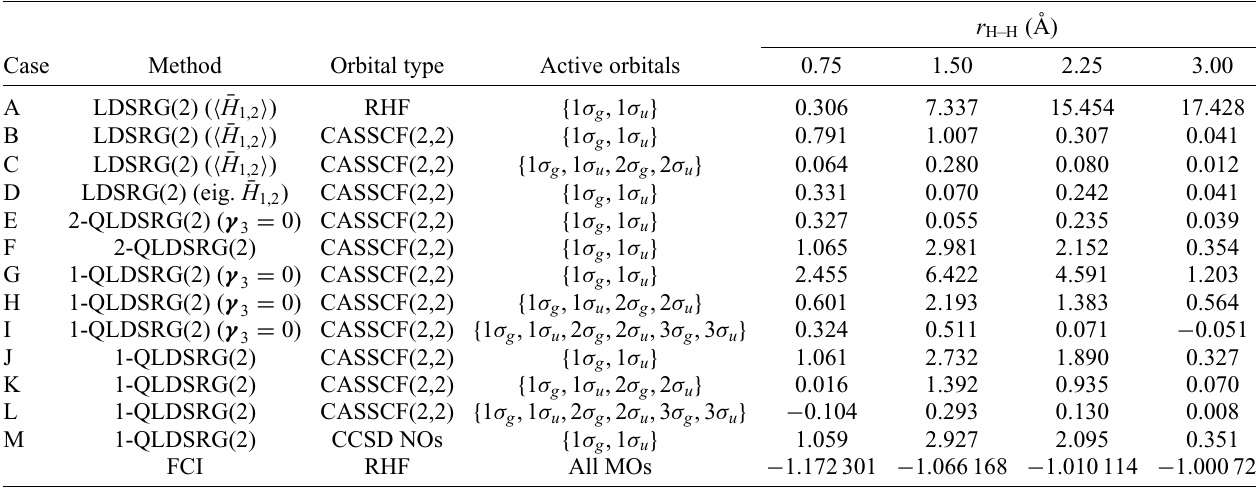
TABLE I. The energy error for the H 2 molecule (in m E h ) computed with the LDSRG(2) and QLDSRG(2) methods. All computations . The energy errors are computed with respect to the full configuration use a cc-pVTZ basis [85] and the flow parameter value s = 0.5 E − 2 h interaction (FCI) energies (in E h ) reported in the last row of the table. For the LDSRG(2), the expectation value of the energy is designated with “ (cid:8) ¯ H 1,2 (cid:9) ,” while the lowest eigenvalue is indicated with “eig. ¯ H 1,2 .” For the QDSRG methods, we report two sets of ˜ λ = 0” use an approximate three-body cumulant reconstructed from ˜ λ data. Those labeled “ γ 1 and 2 . The results for line M employ 3 CCSD natural orbitals and the one-body relaxed CCSD reduced density matrix as input to the QDSRG